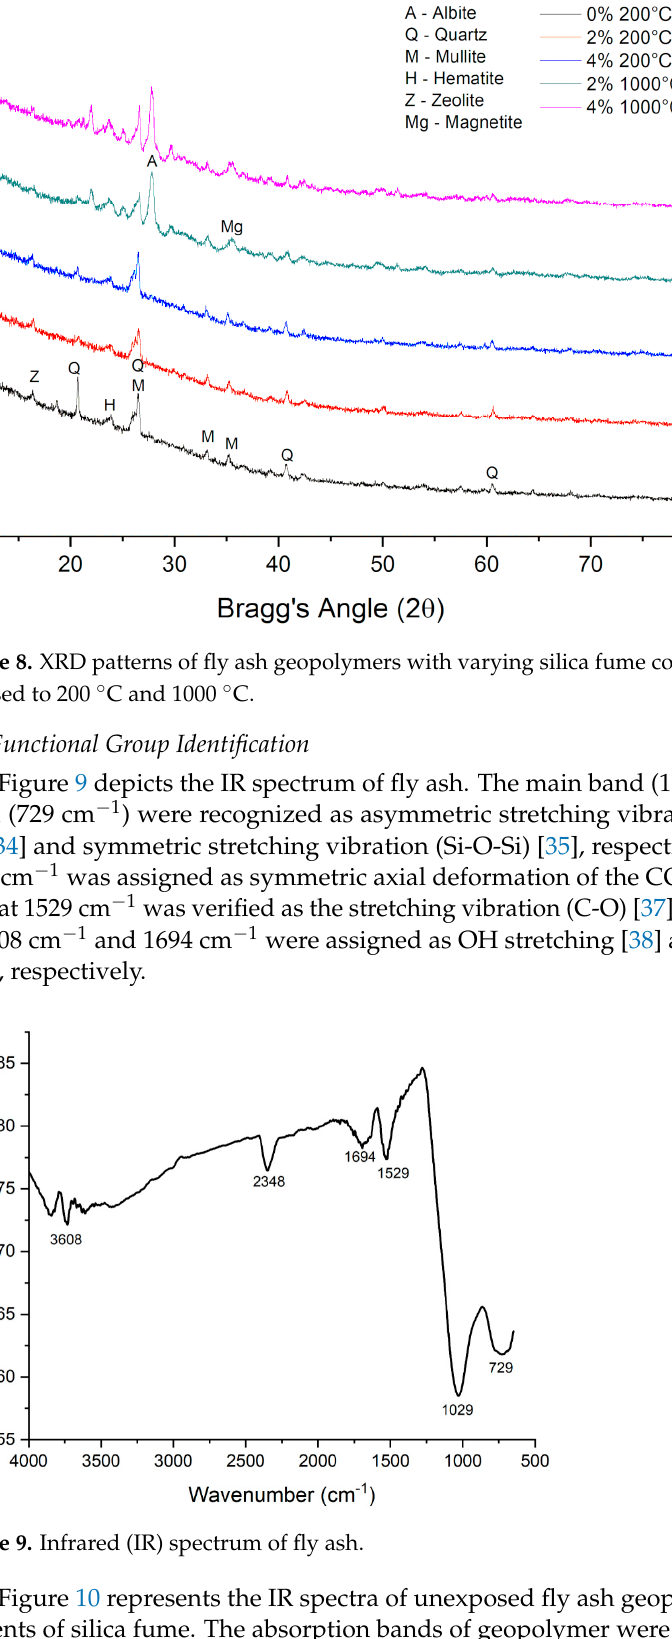
Figure 10. IR spectra of un-exposed fly ash geopolymers with varying silica fume content addition. The addition of silica fume did not alter or produce a new absorption band in geo- polymer. Increasing the silica fume content increased the wavenumber from 983 cm − 1 to